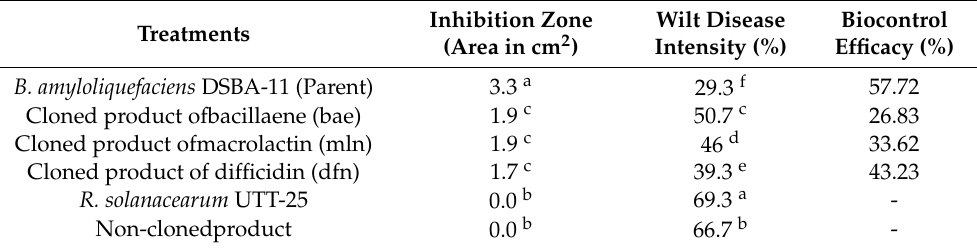
Figure 6. Inhibition zone formed by clone product of polyketide antibiotic synthase genes of Ba- cillu s amyloliquefaciens DSBA-11 against R. pseudosolanacearum. ( A ) B. amyloliquefaciens DSBA-11 (Wild strain) ( B ) clone of difficidin gene ( C ) clone of macrolactin gene ( D ) bacillaene gene. Table 4. Formation of inhibition zone and reduction of bacterial wilt disease intensity by-product of polyketide antibiotics synthase gene cloned and parent strain of B. amyloliquefaciens DSBA-11. Inhibition Zone Treatments (Area in cm 2 )